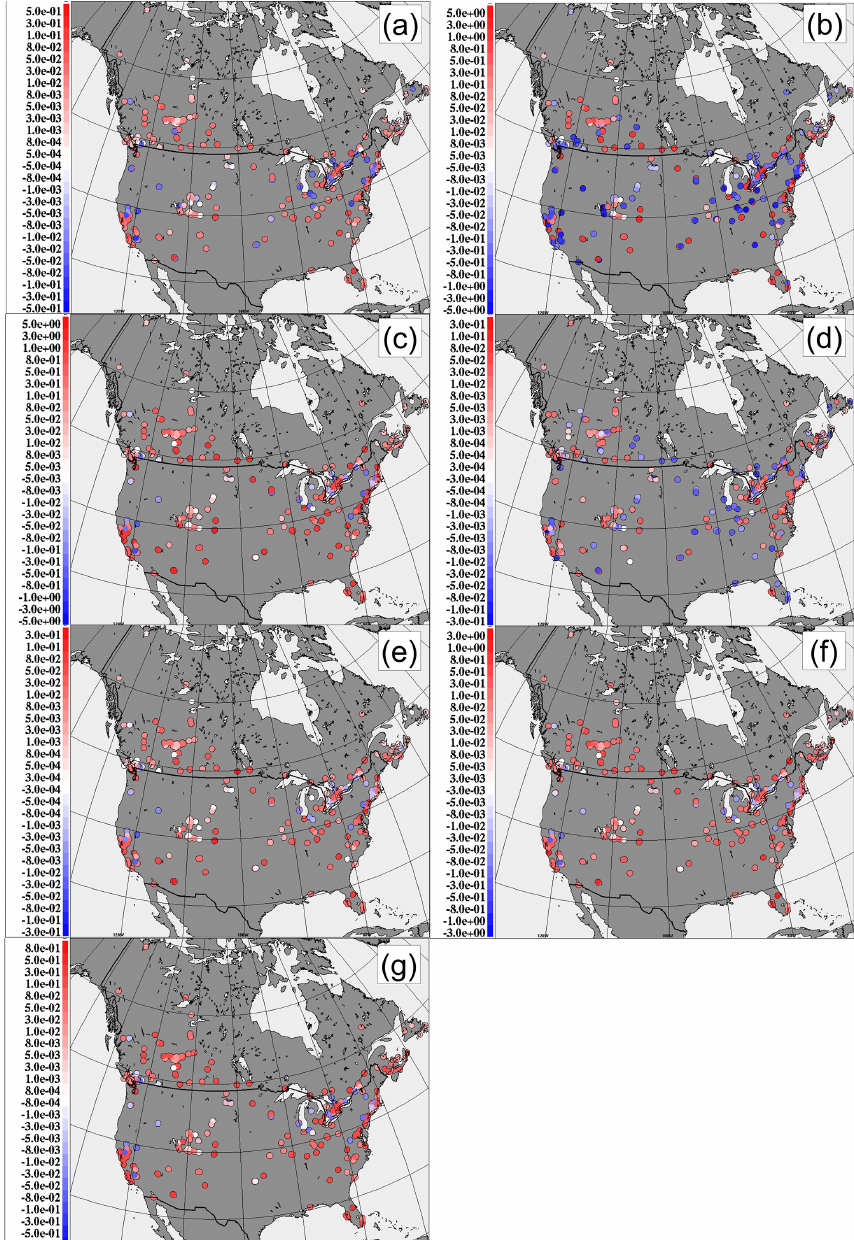
Figure 9. Change in model NO 2 performance at 358 North American surface monitoring sites, July 2016 (ppbv). Red colors indicate stations where the addition of the VIT parameterization improved model performance; blue colors indicate stations where the addition of the VIT parameterization degraded model performance. (a) (cid:49) FAC2 VIT–No VIT ; (b) (cid:49) | MB | No VIT–VIT ; (c) (cid:49) MGE No VIT–VIT ; (d) (cid:49)r VIT–No VIT ; (e) (cid:49) RMSE No VIT–VIT ; (f) (cid:49) COE VIT–No VIT ; (g) (cid:49) IOA VIT–No VIT